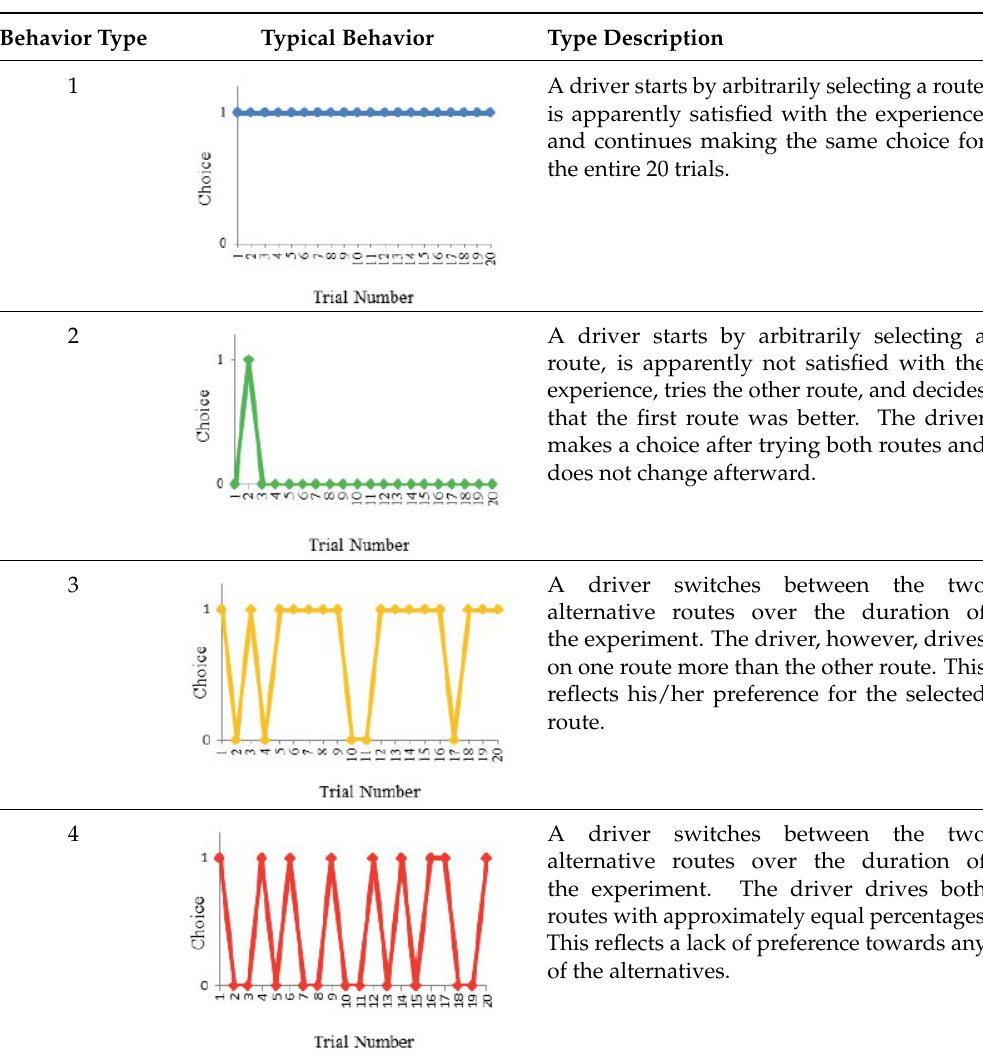
Table 1. Four identified behavioral driver types